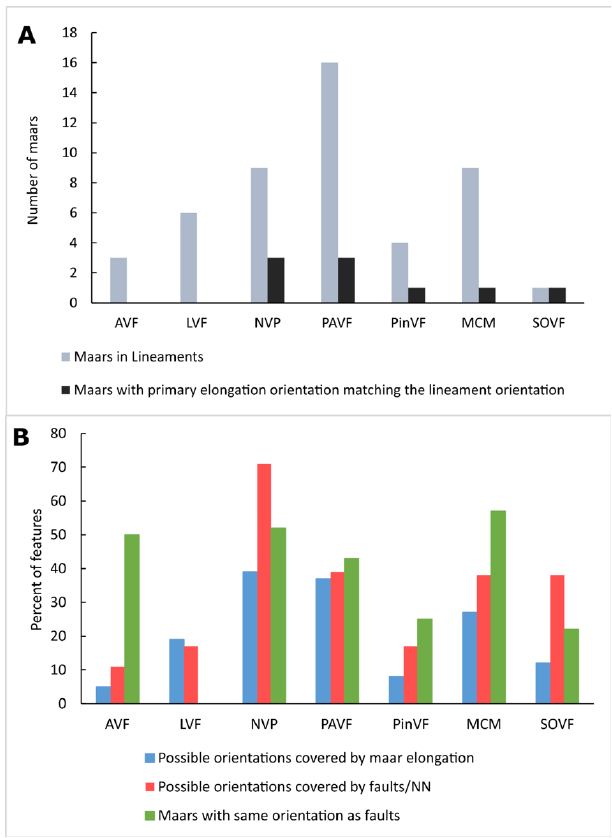
Figure 13: Comparisons of maar orientations relative to other metrics to contextualize the results. [A] The occur- rence of maars in lineaments and how many of those maars have primary elongations that match the linea- ment. [B] Comparison of the percent of possible orien- tations (out of 360 degrees) of maar orientations and stress